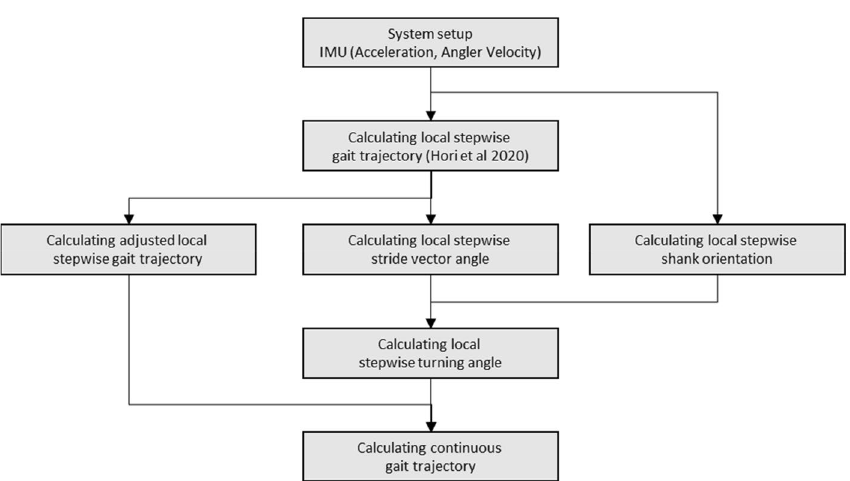
Figure 9. Flow chart of proposed method for estimating continuous gait trajectory using single shank-worn